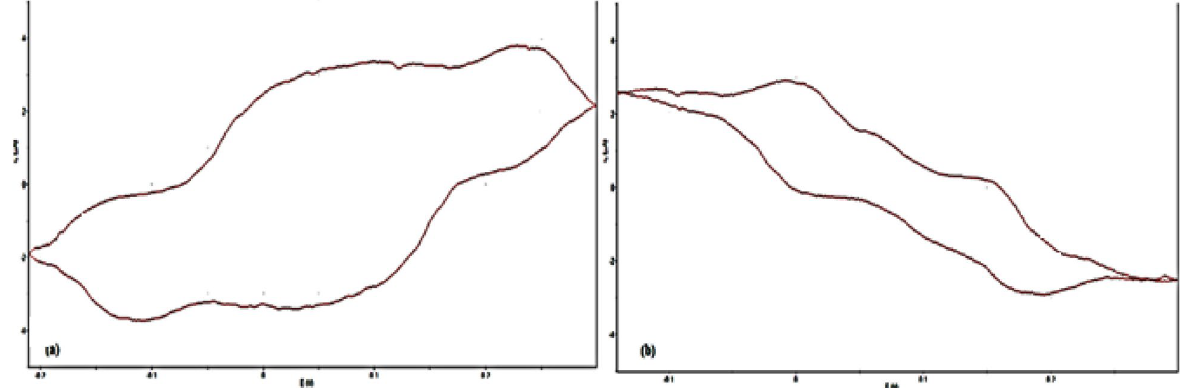
Fig. 5 Cyclic voltammetry (50 mV/s) of: ( a ) copolymer 6; and ( b ) copolymer/L-hexuronic acid/SiO 2 @Ag nanocomposite 7 in DMSO